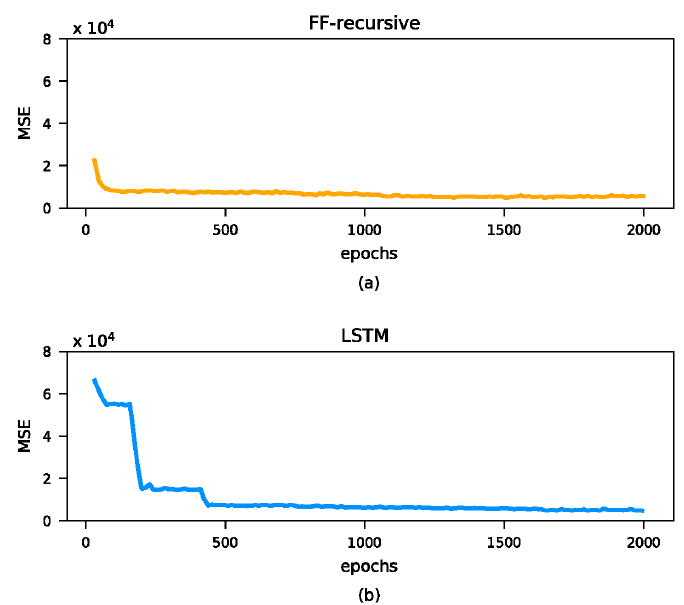
Figure 8. Evolution of the MSE across the training epochs for recursive FF ( a ) and LSTM ( b ) predictors.